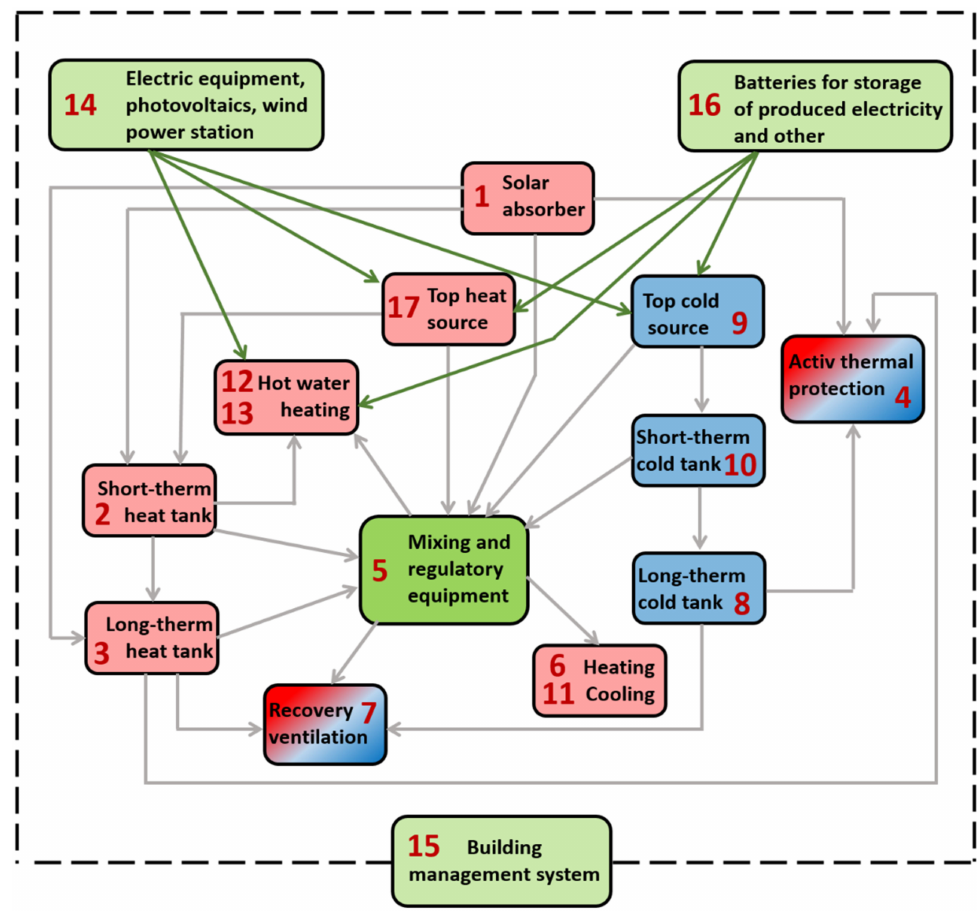
Figure 6. Variants of power equipment cooperate in different modes of